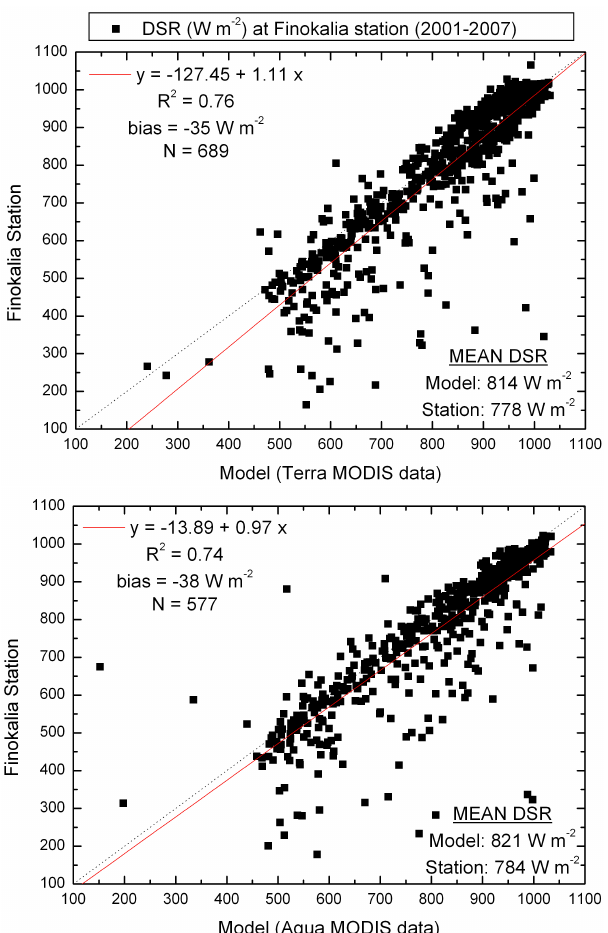
Fig. 5. Scatter plots of the model instantaneous DSR using MODIS Terra (a) and Aqua (b) data, against corresponding ground mea- surements from the Finokalia station, for the years 2001-2007. The lines are the linear regression fits, with the equations, determination coefficients, biases, number of points and mean DSR values shown.